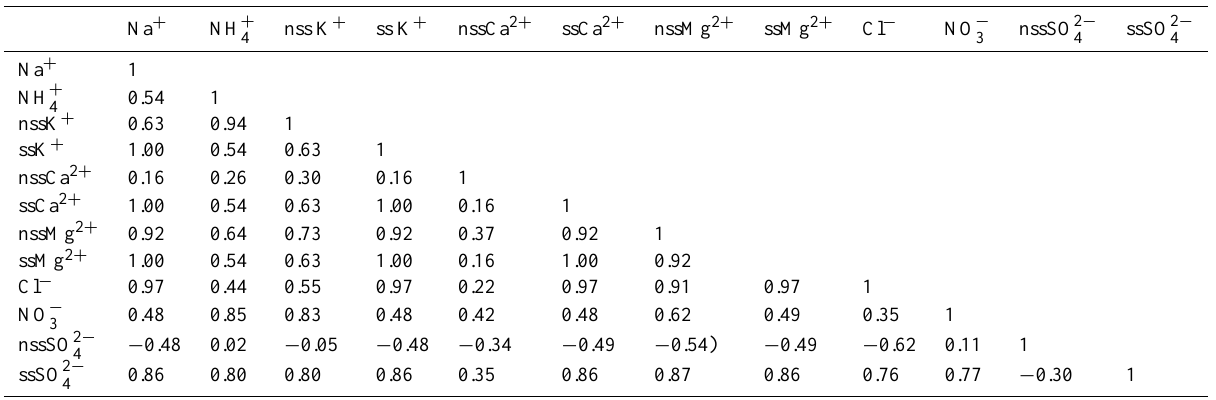
Table 4. Correlation coefficients ( r ) of major ions in winter aerosols from Cape Hedo, Okinawa. Na + NH + nss K + ss K + nssCa 2 + ssCa 2 + nssMg 2 + ssMg 2 + Cl − NO − 4